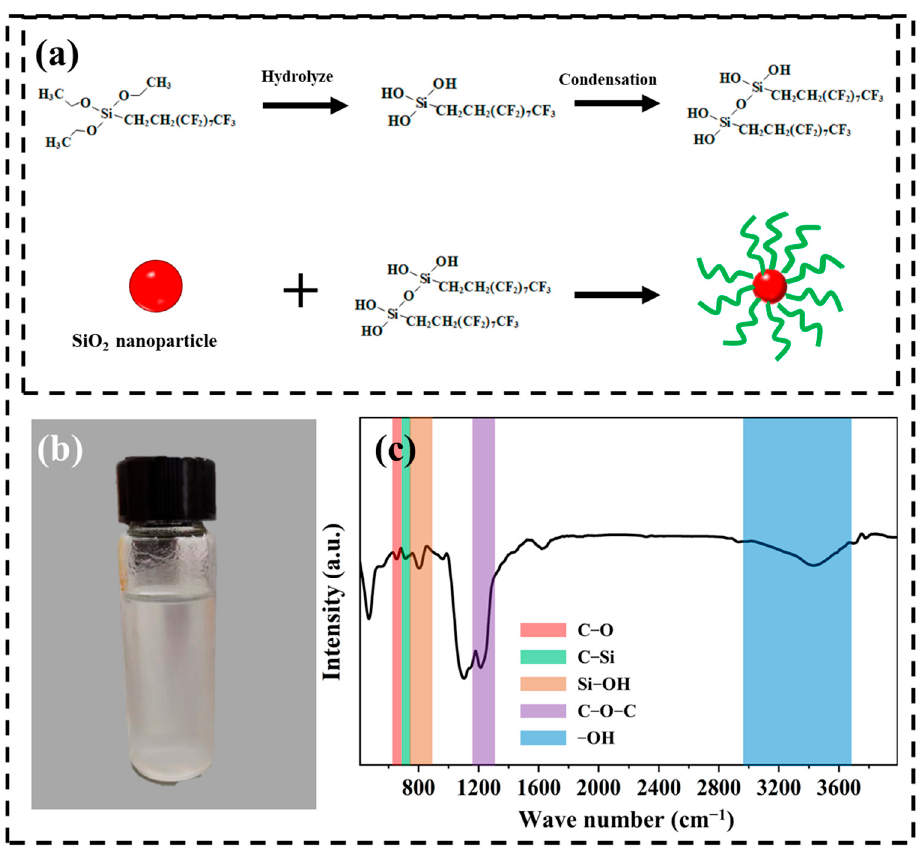
Figure 3. ( a ) Modification process of superhydrophobic particles; ( b ) digital photos of alcohol sols; ( c ) infrared spectra of particles before and after modification.